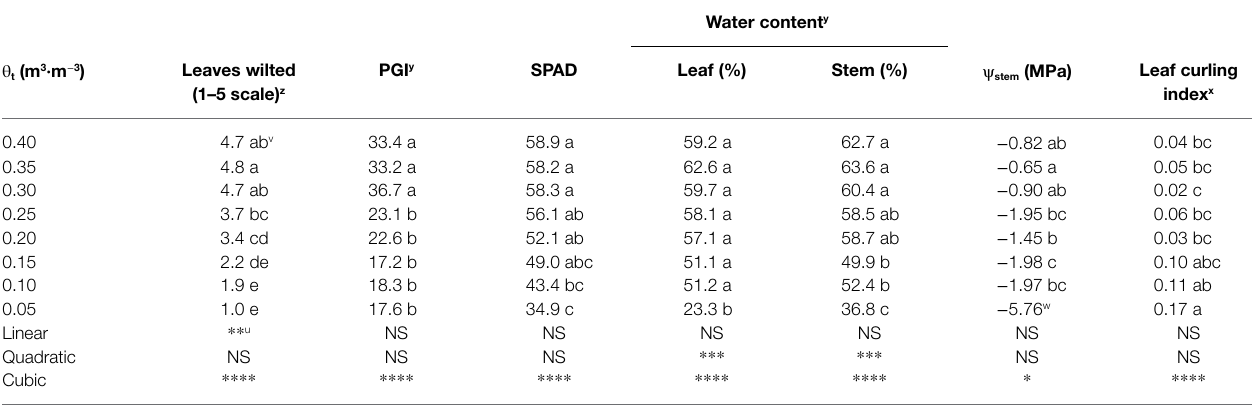
TABLE 2 | Degree of leaves visibly wilted, plant growth index (PGI), relative chlorophyll content [Soil Plant Analysis Development (SPAD) value], water content of leaves and stems, stem water potential ( ψ stem ), and leaf curling index of Shepherdia ×utahensis at eight substrate volumetric water content treatments ( θ t ).